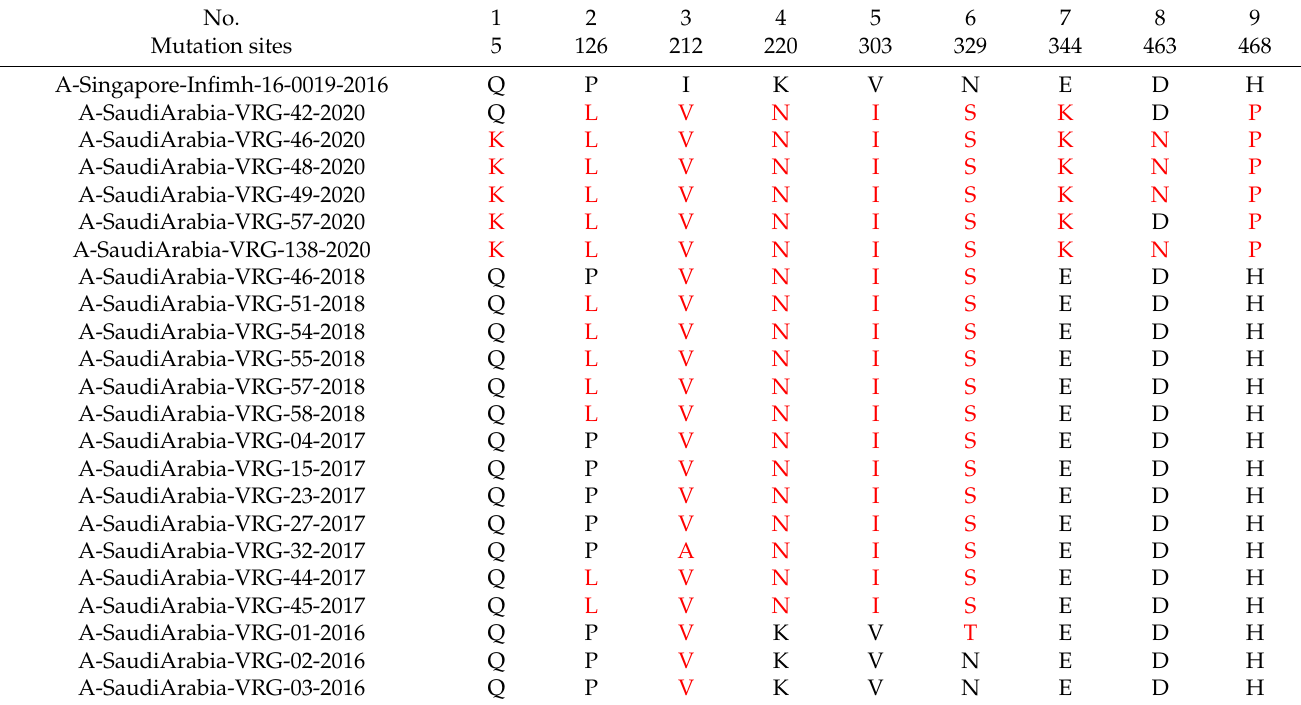
Note: red alphabets: sites where amino acid changes occur. Table 4. Amino acid changes in the NA of Saudi H3N2 strains in comparison to the vaccine strain. No. Mutation